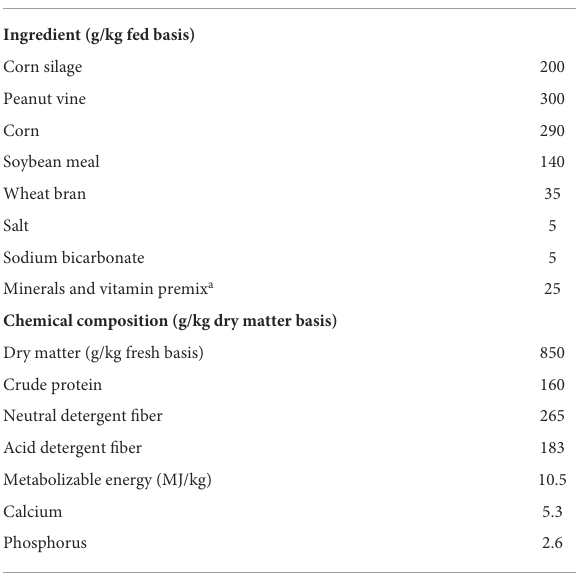
TABLE 1 Ingredients and chemical composition of the basal diet. Items